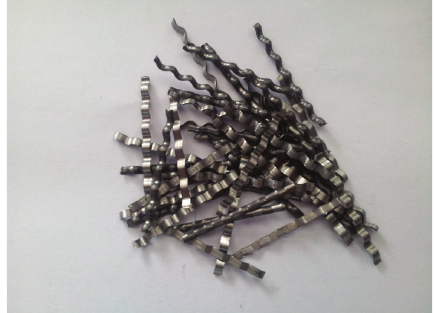
Table 2: Physical properties of nano-SiO